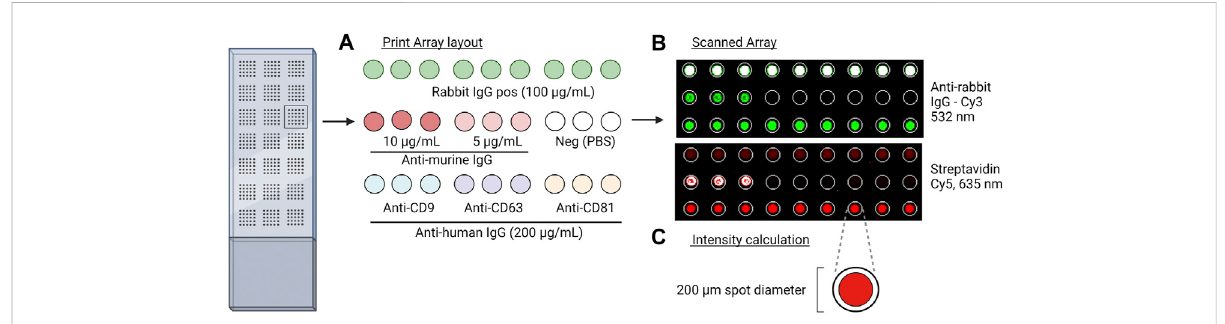
FIGURE 1 Overview of the EV Array method. (A) Print layout of antibodies (murine anti-human IgG), positive control (biotin-labeled anti-murine IgG and rabbit IgG), and negative control (PBS) for the analysis. Slides were placed into a 96-multi-well cassette, and 10 µL of the sample was added and incubated overnight. After the addition of detection antibodies and fl uorescent molecules, the slides were scanned. (B) Scanned images at 635 nm and 532 nm of controls and captured EVs by the murine and rabbit antibodies, respectively. (C) Fixed spot area with a diameter of 200 µm applied for quantitative analysis.